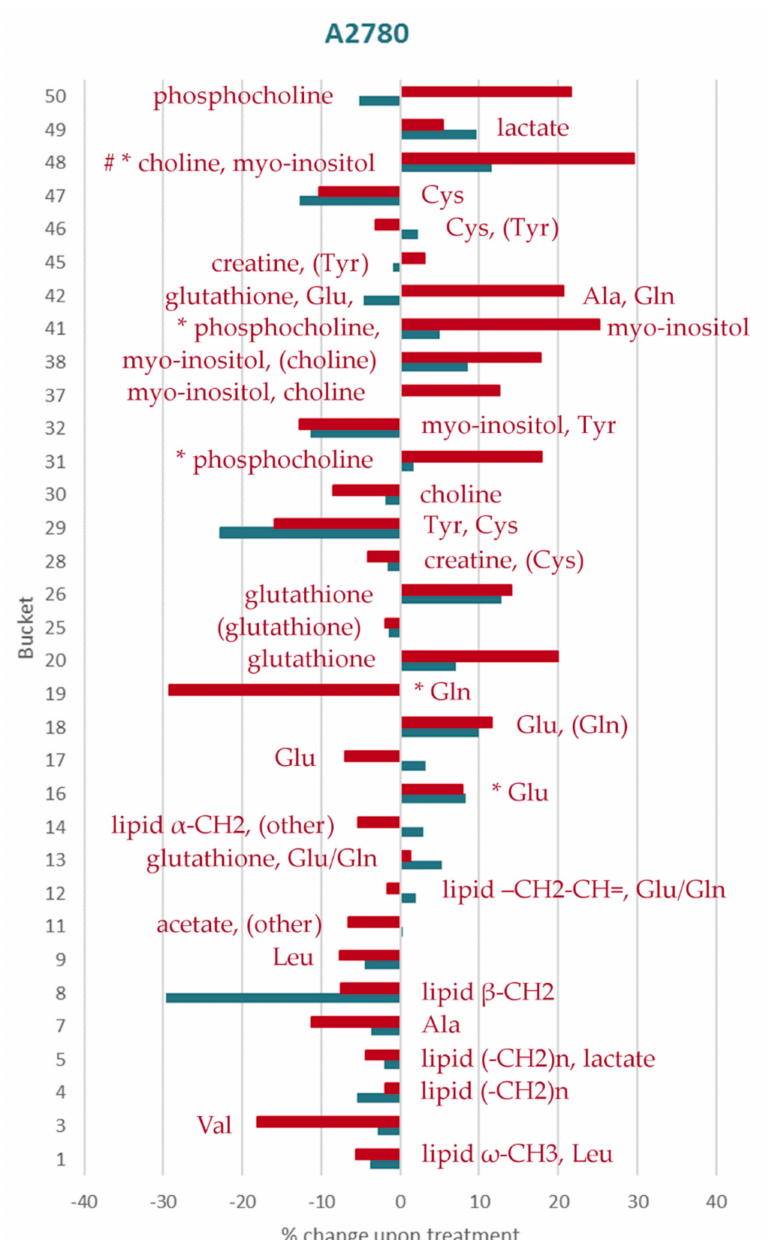
Figure 5. Percental change in the assigned aliphatic buckets in A2780 cells: The increasing / decreasing levels of each bucket compared to the control in cells treated with 0.015 µ M of DiRu-1 (blue) and 0.03 µ M of DiRu-1 (red) are expressed in percentages. The buckets marked with * show p -values < 0.05. The buckets marked with # show Benjamini–Hochberg-corrected p -values < 0.05. The complete bar plot also containing unidentified buckets is given in Figure